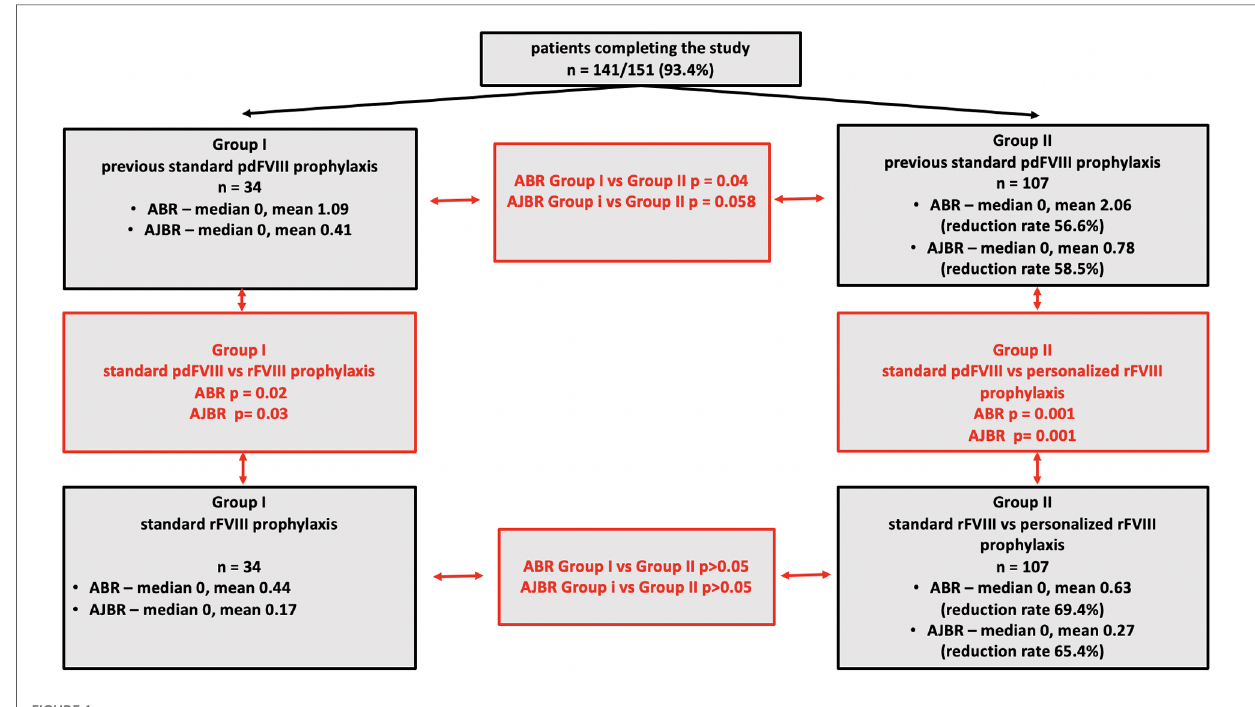
FIGURE 1 The graphic summary of the study and its